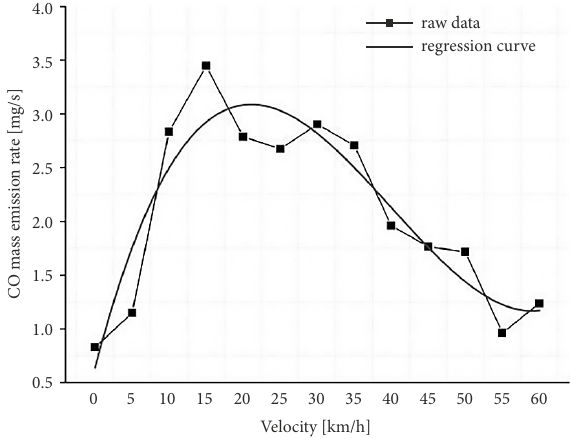
Figure 11. Velocity–emission rate regression curve of CO